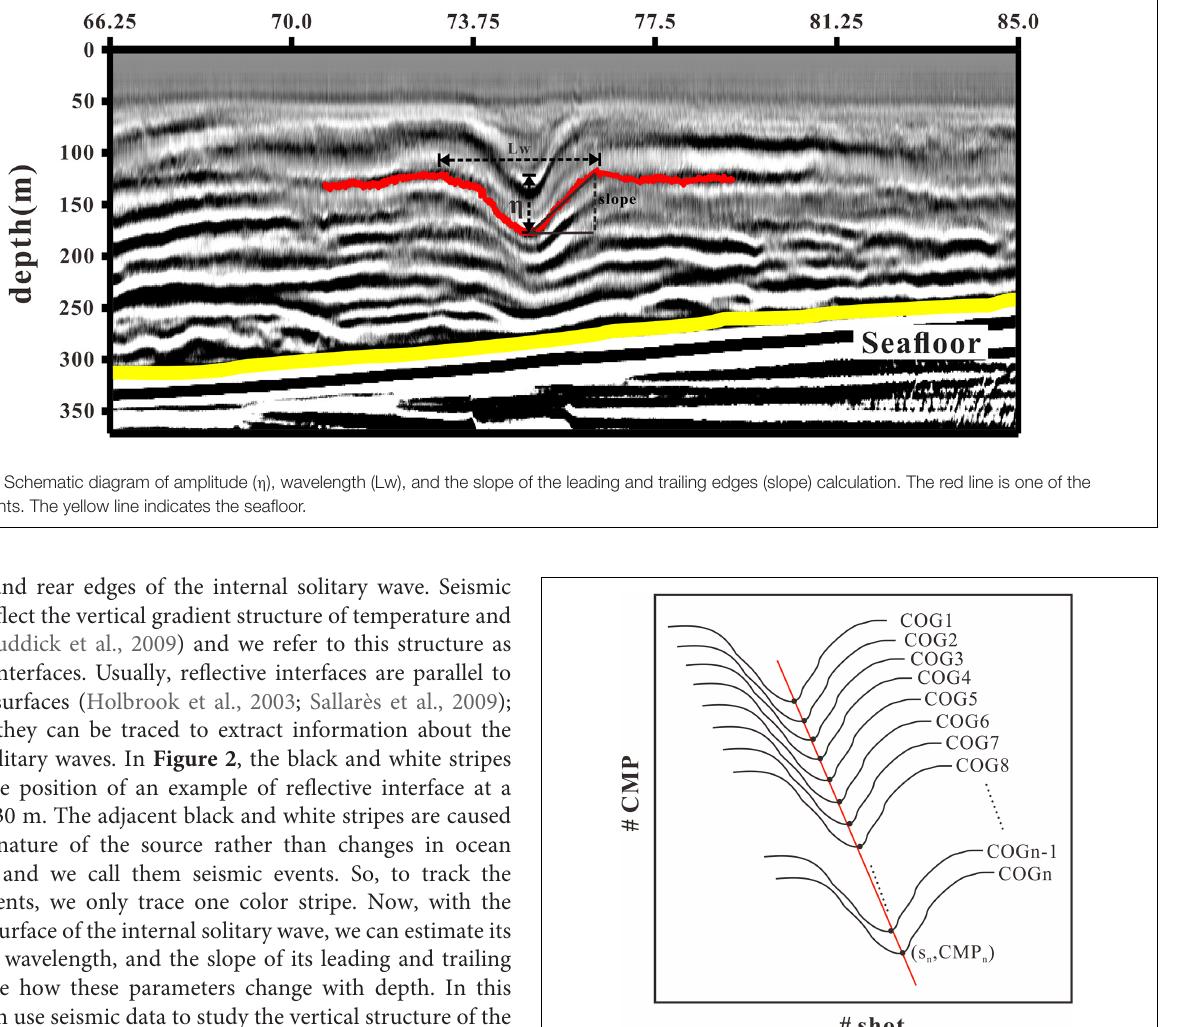
FIGURE 3 | Schematic diagram of calculating the internal solitary wave phase velocity by using pre-stack seismic